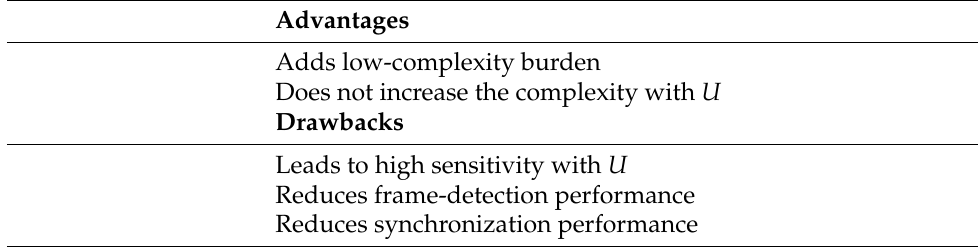
Table 5. Advantages and drawbacks of legacy